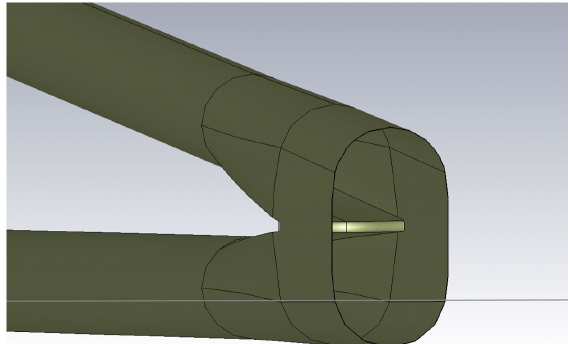
FIG. 10. Inside and outside view of the transition in the IR model